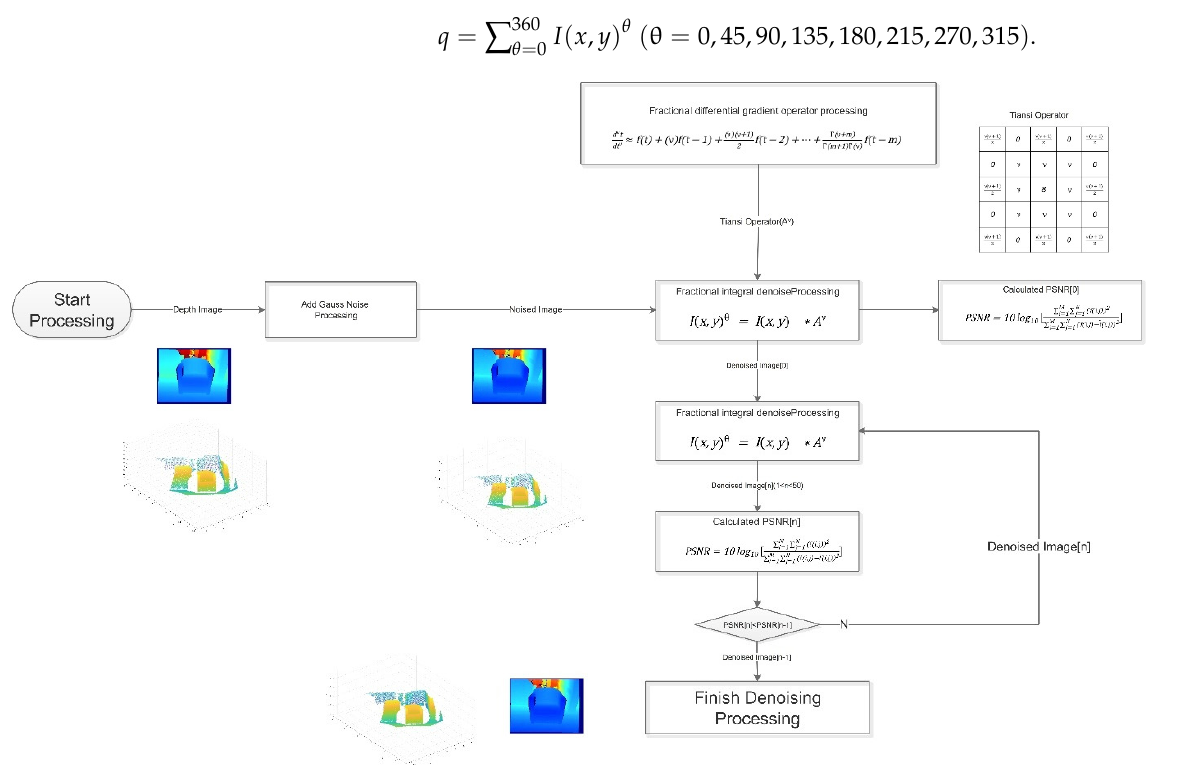
Figure 5. Fractional integral operator denoising flow chart.